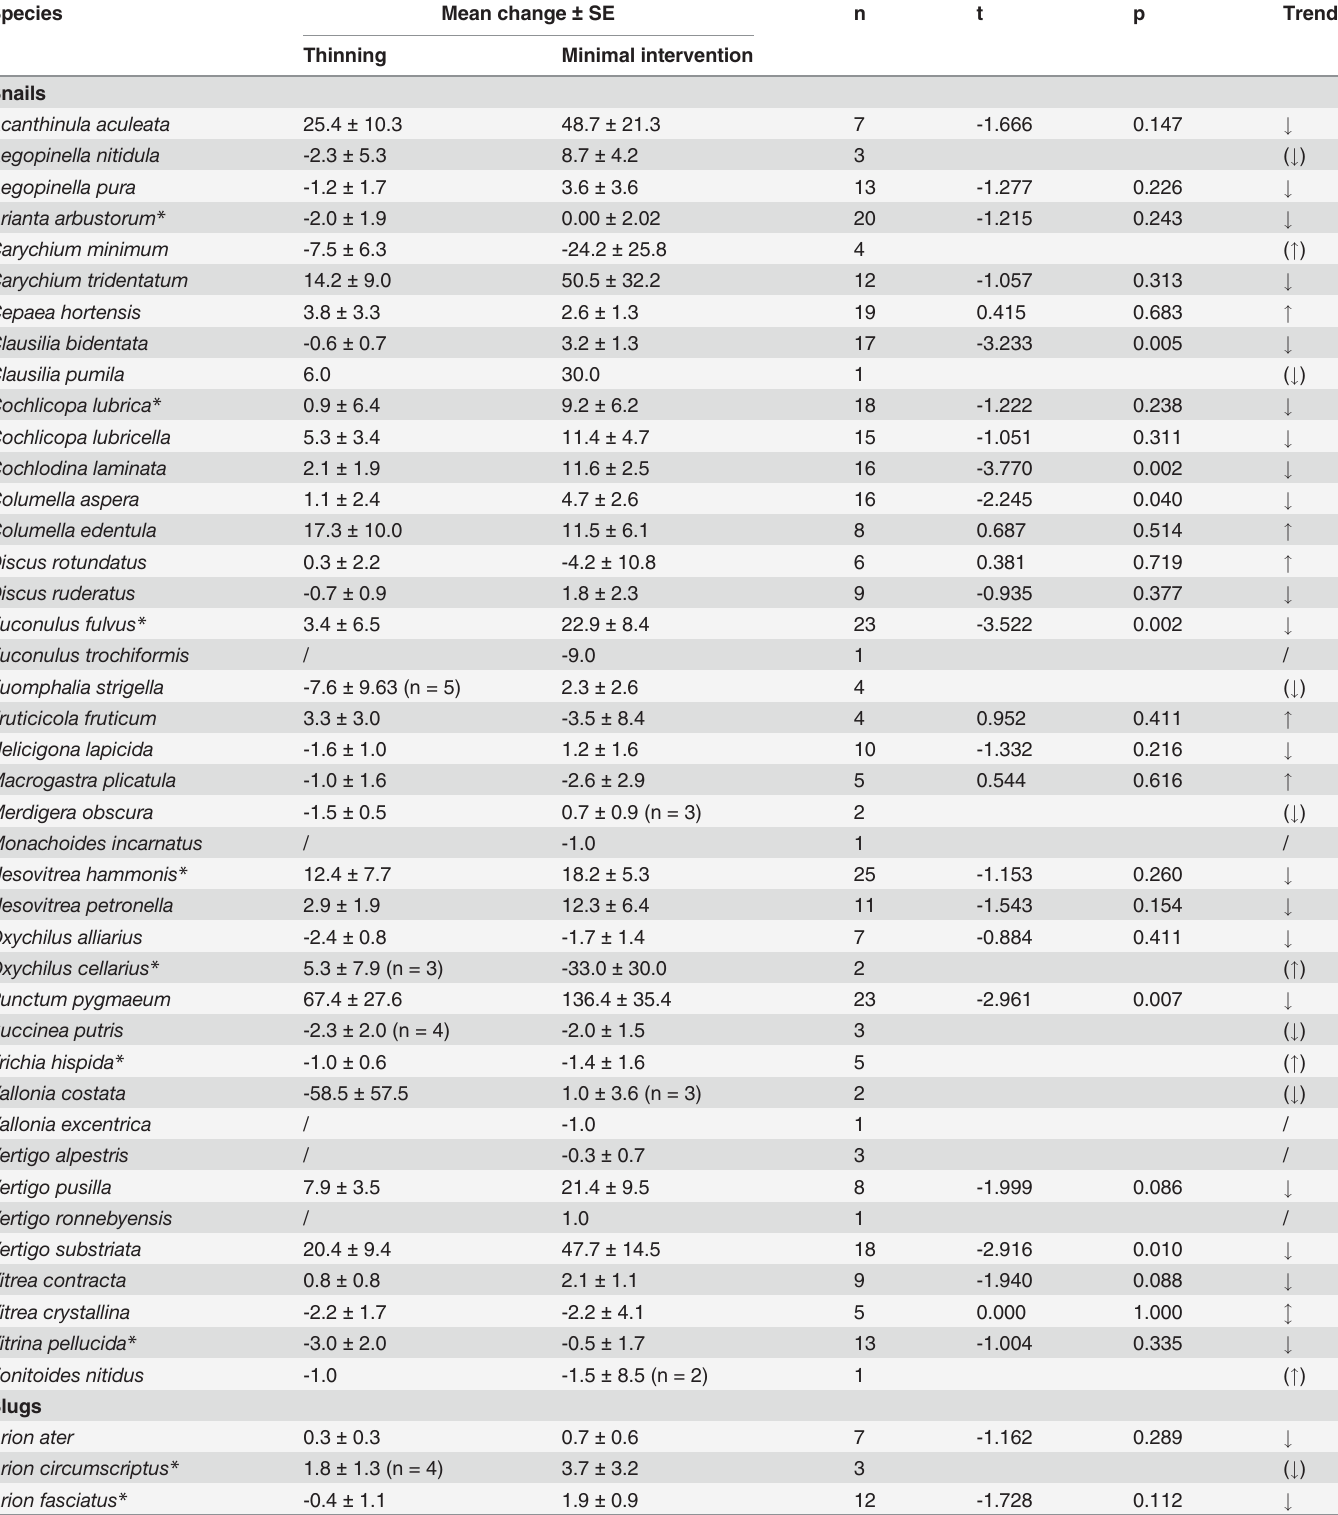
Table 3. Mean change in abundance and results of paired t-tests for each species; * indicates non-forest-species. Species Mean change ± SE n t p Trend Thinning Minimal intervention